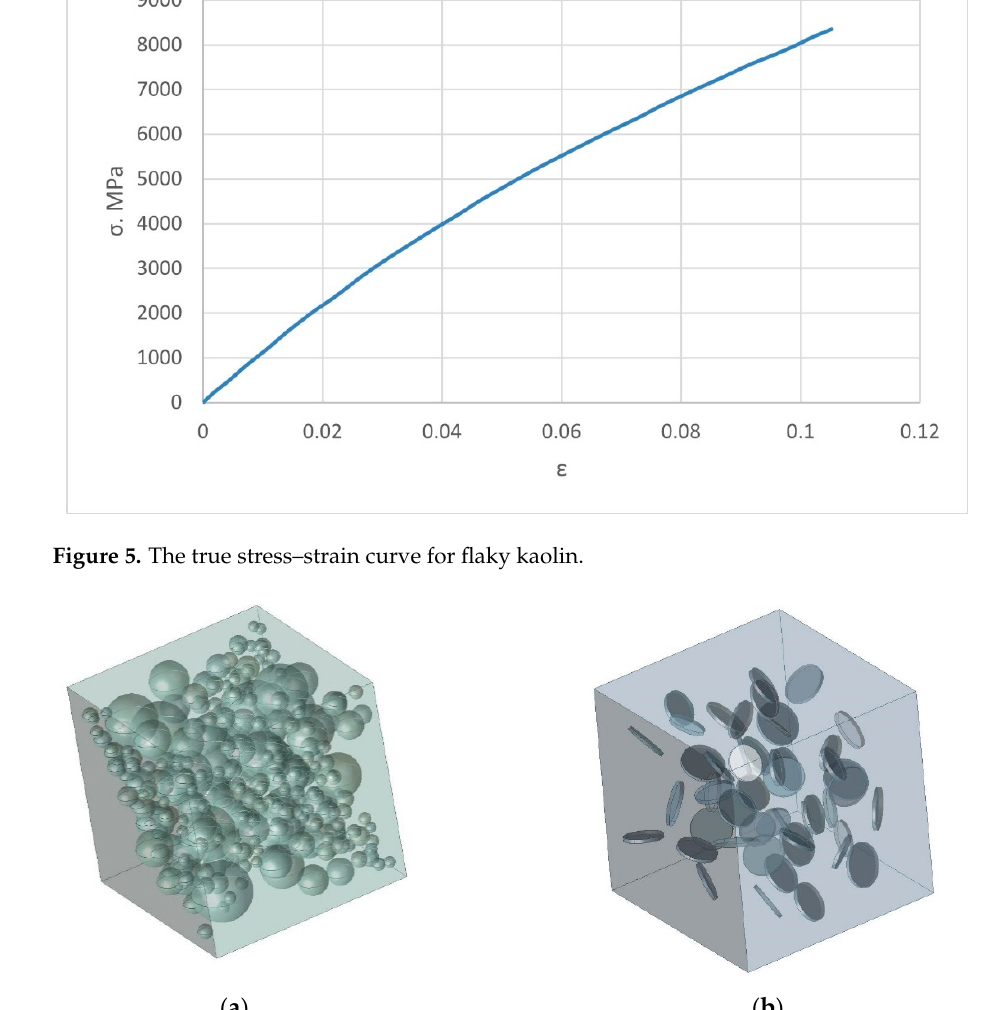
Figure 6. A solid-state model of composite materials randomly reinforced with spherical ( a ) and short cylindrical ( b ) inclusions.